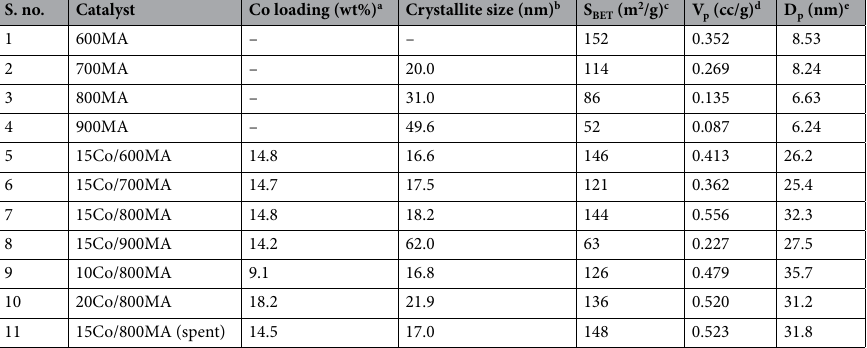
Table 1. Physicochemical characteristics of MgAl 2 O 4 spinel synthesized at different activation temperatures and its corresponding cobalt supported catalysts. a Cobalt loading determined from ICP-OES. b Calculated using Scherrer equation by substituting the FWHM value from the lattice plane (311). c Specific surface area of the calcined sample is derived from BET equation. d Total pore volume. e Pore diameter (calculated by BJH method from desorption